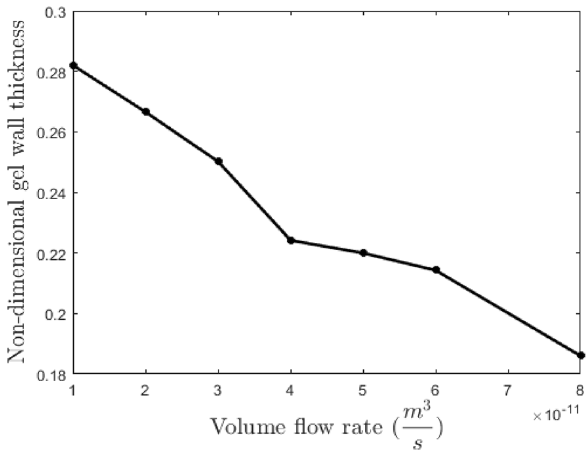
Fig. 7 Changes in gel wall thickness as a function of both volume flow rates of Pluronic and saline solution